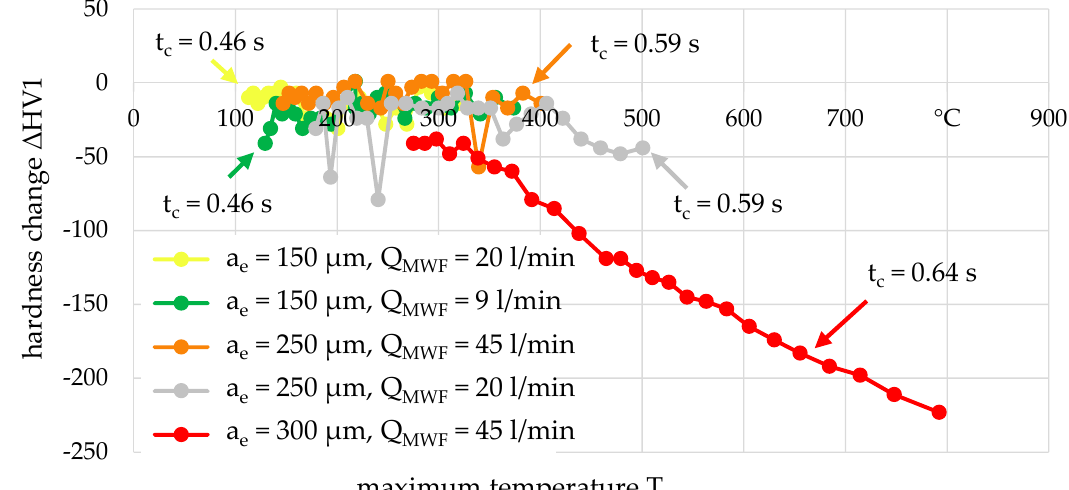
Figure 8. Hardness change dependent on the maximum temperature for different process parameter combinations